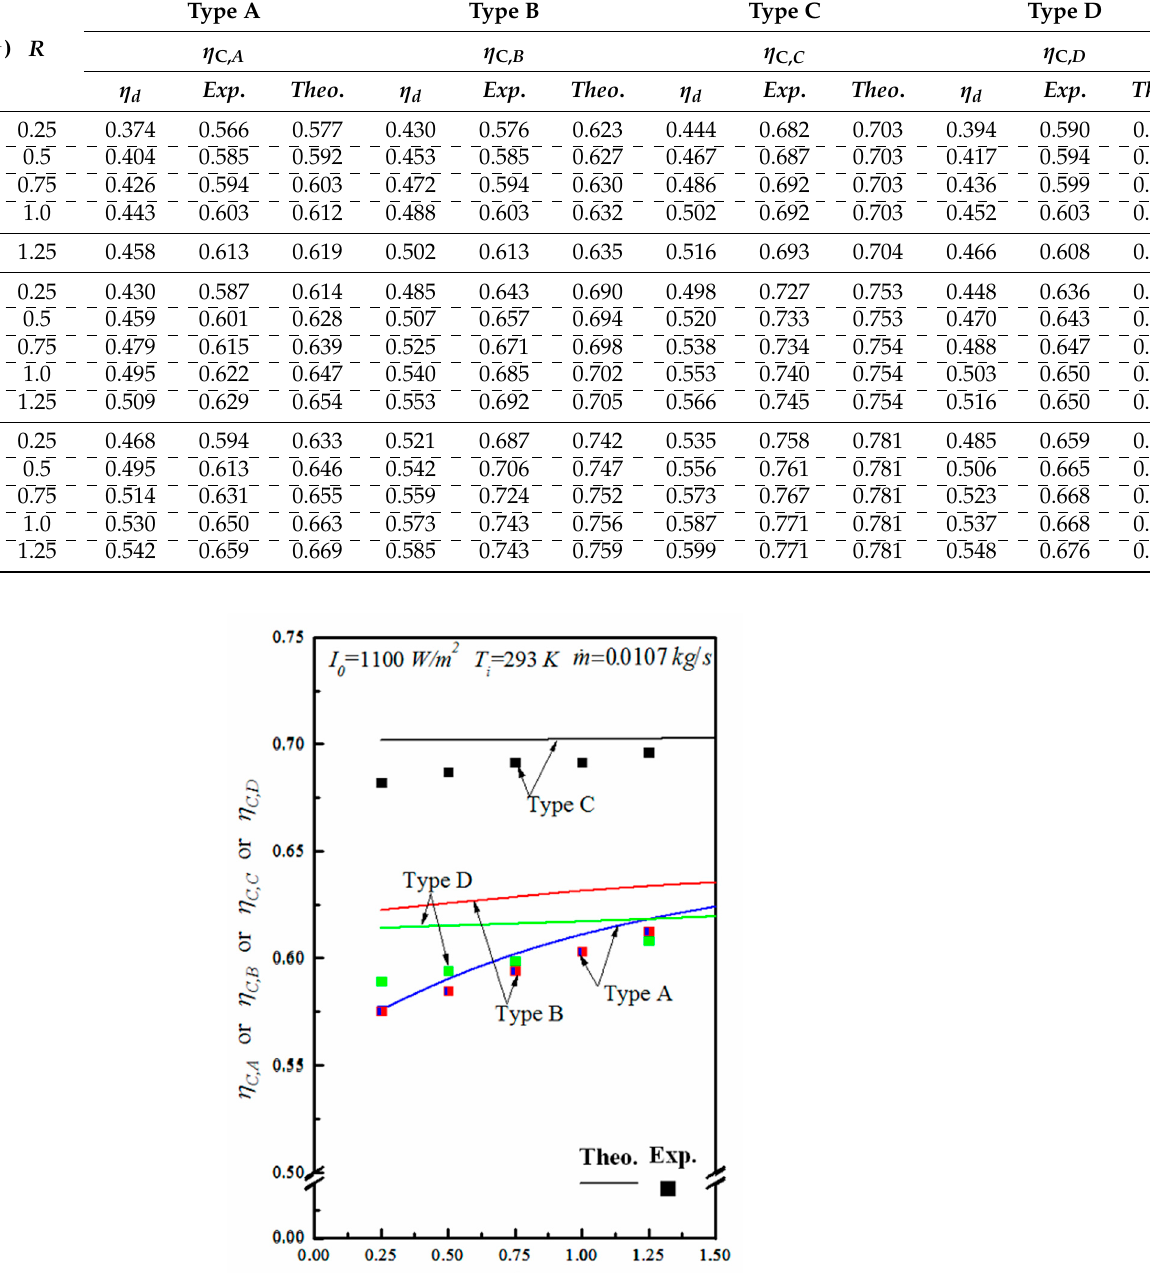
Table 4. Effects of external-recycle types and recycle ratios on collector efficiency improvements.